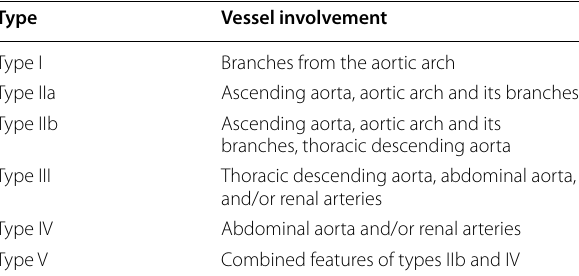
Table 1 Classification of TA from the Takayasu Conference